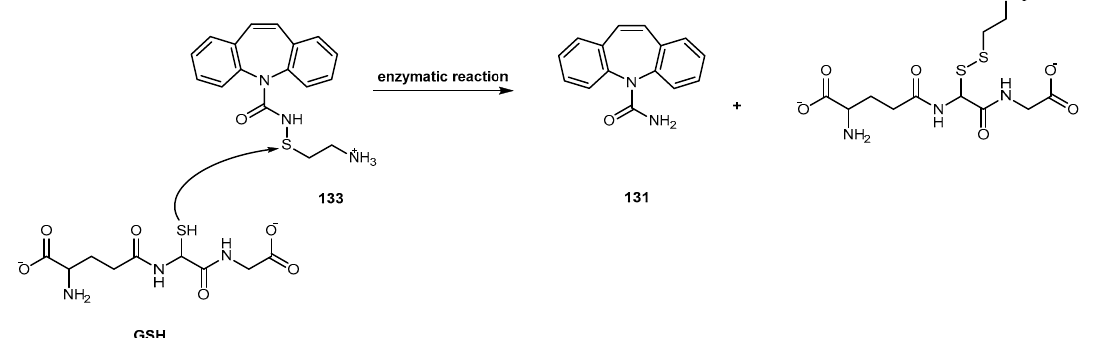
Figure 53. Possible conversion mechanism of N -cysteamine carbamazepine (133) to the parent drug 131 by the nucleophilic attack by GSH (adapted from [4]).